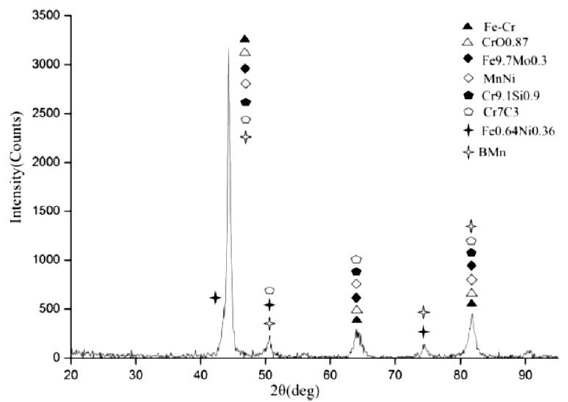
Figure 12. XRD results of LAM FeCr alloy.